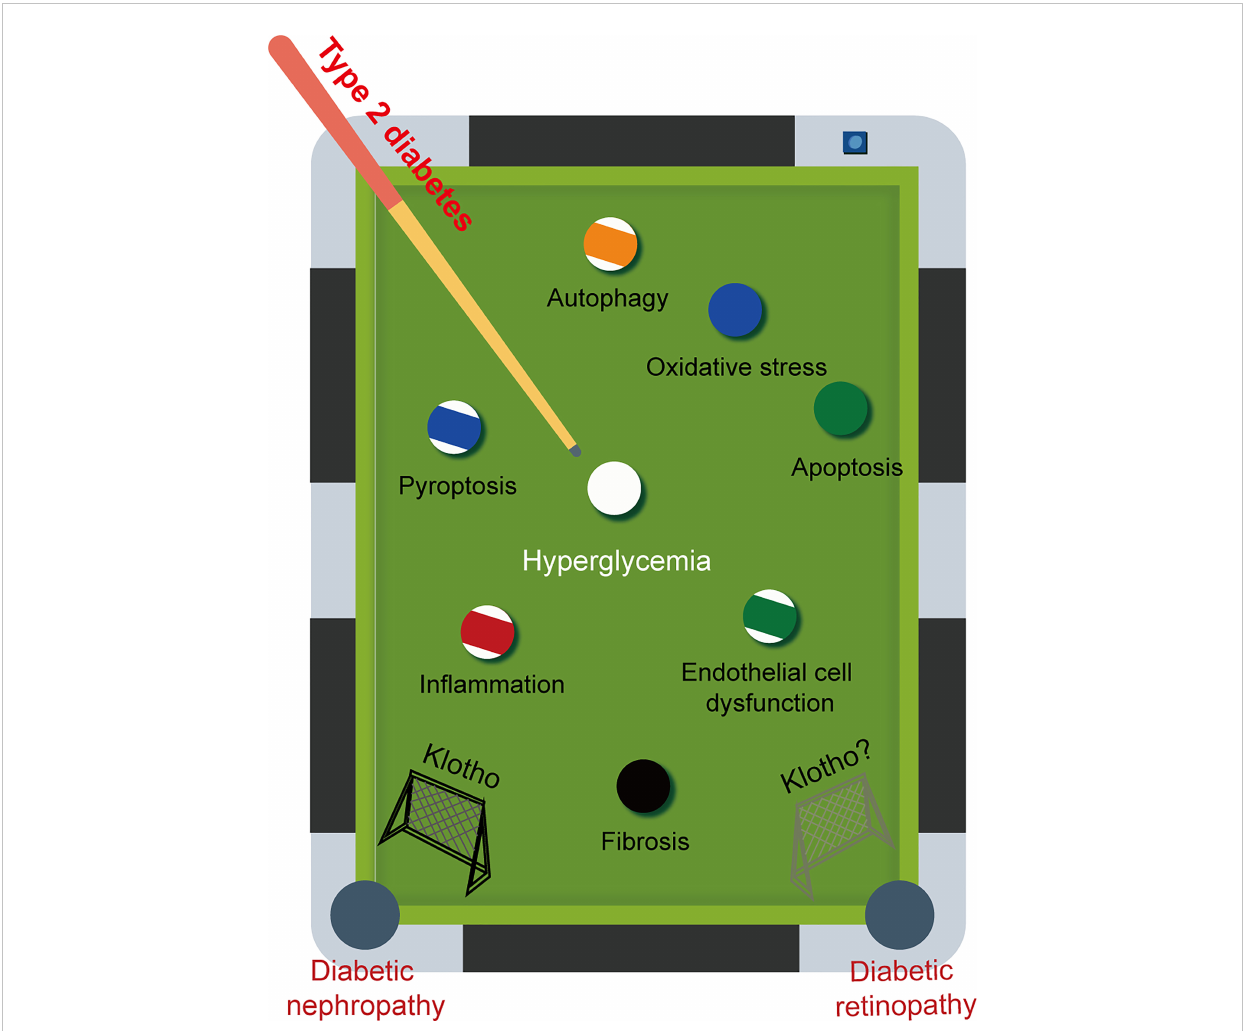
FIGURE 4 The game between pathogenic factors and Klotho. Diabetic retinopathy (DR) and diabetic nephropathy (DN) are two major microvascular complications that commonly occur in late-stage diabetes. These complications share common pathogenic mechanisms. Given the multiple bene fi cial effects of Klotho on DN, it is reasonable to speculate that Klotho may also have a positive effect on